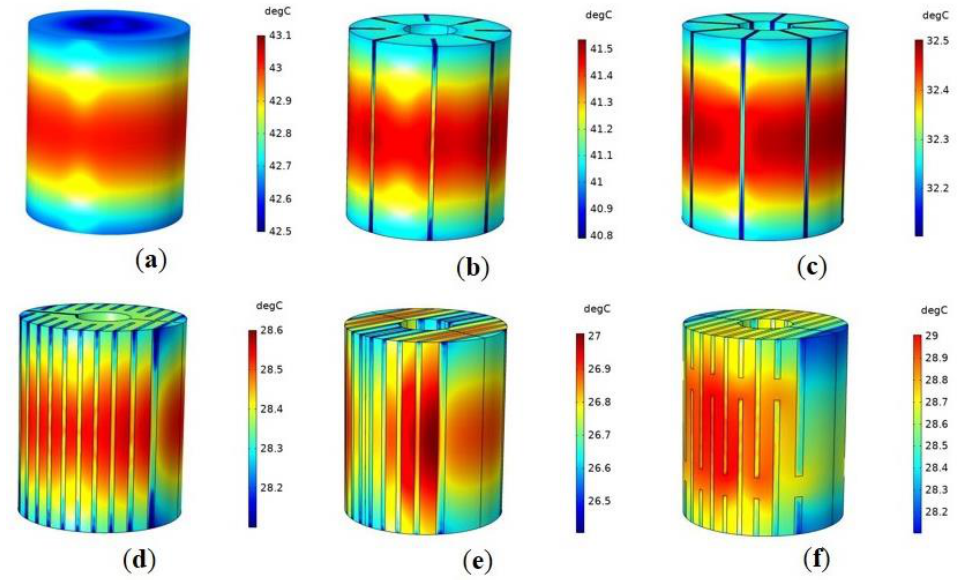
Figure 3. Temperature distribution of Terfenol-D rods with different structures when working for 30 min: ( a ) Untreated; ( b ) Radial slit; ( c ) Radial cut and bonded; ( d ) Sliced and grooved; ( e ) Slice treatment; ( f ) Sliced at both ends.